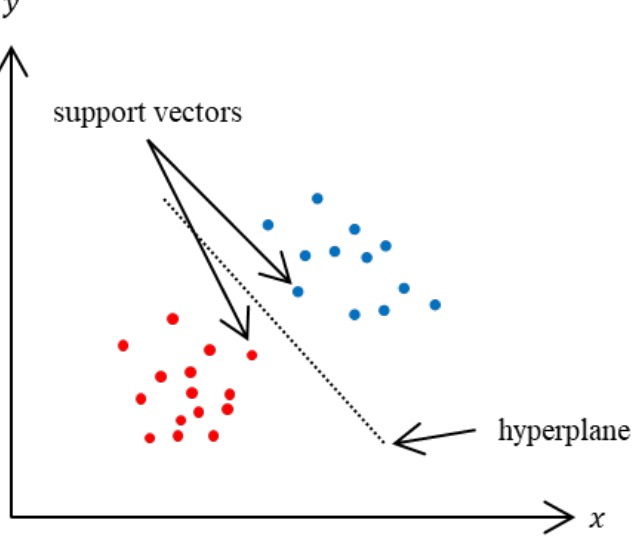
Figure 8. SVM classification for 2 classes.